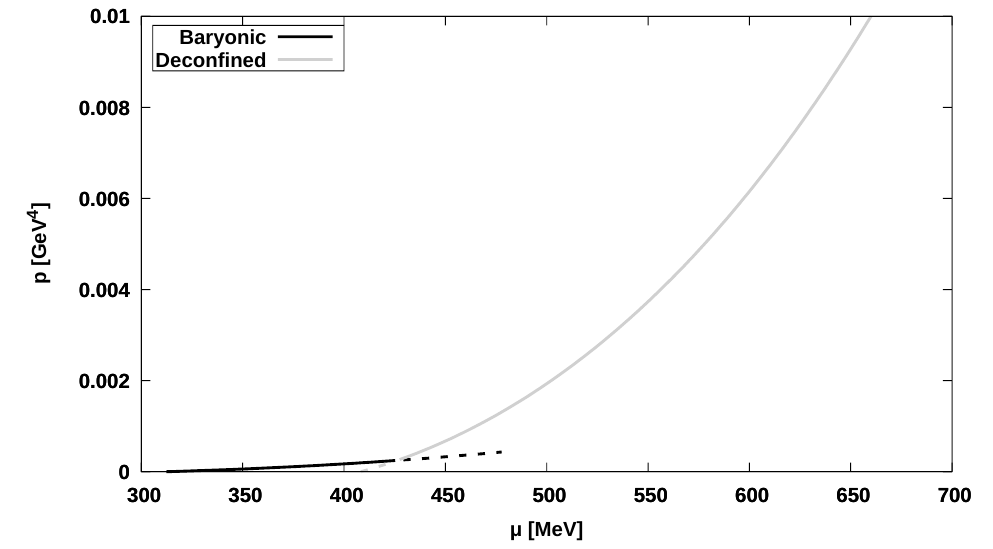
Figure 3 . Pressure at T = 0 using the homogeneous ansatz for the baryon phase. Metastable branches are denoted by dashed